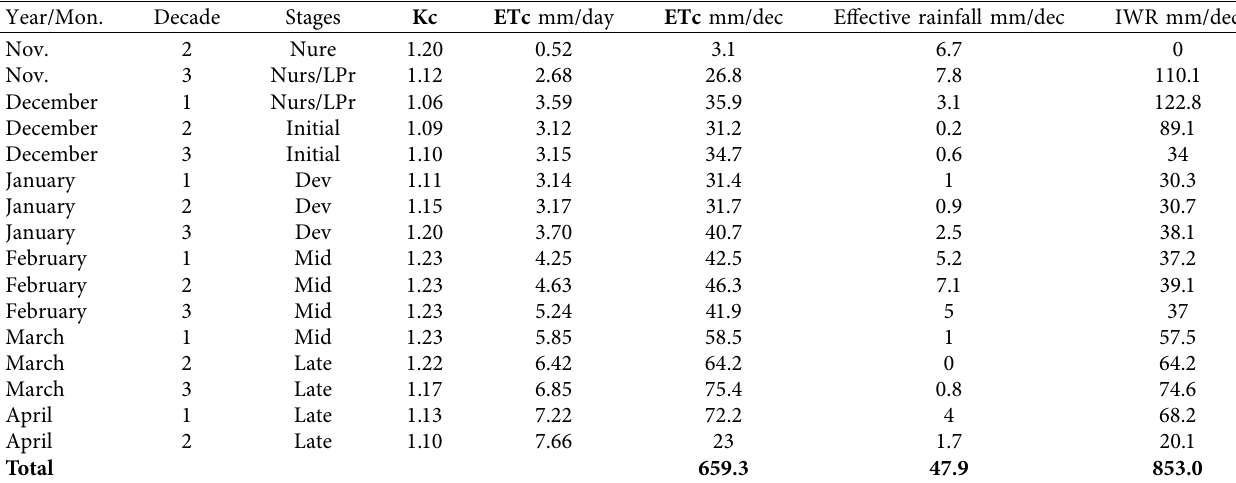
Table 3: CWR of wheat at different stages.